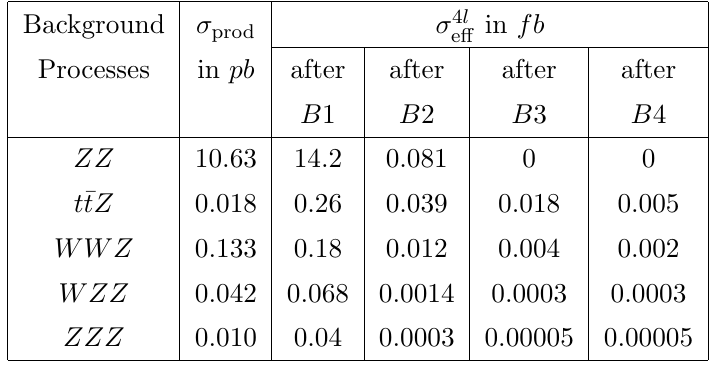
) after the cuts for di(cid:11)erent SM back- e(cid:11)